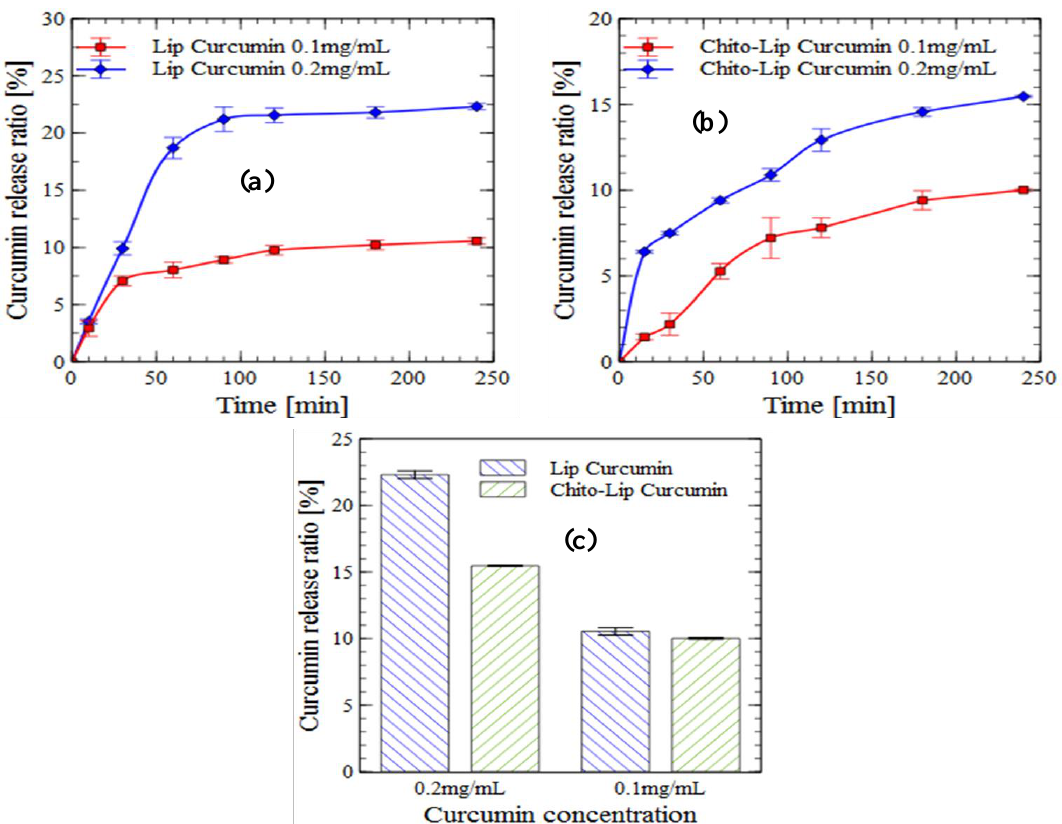
Figure 2. In vitro release (PBS solution) of curcumin encapsulated in nanoliposomes ( a ) and chitosan-coated nanoliposomes ( b ) (values reported are mean ± SD; n = 3), and the proportions of released curcumin from nanoliposomes and chitosan-coated nanoliposomes after four hours of incubation ( c ).